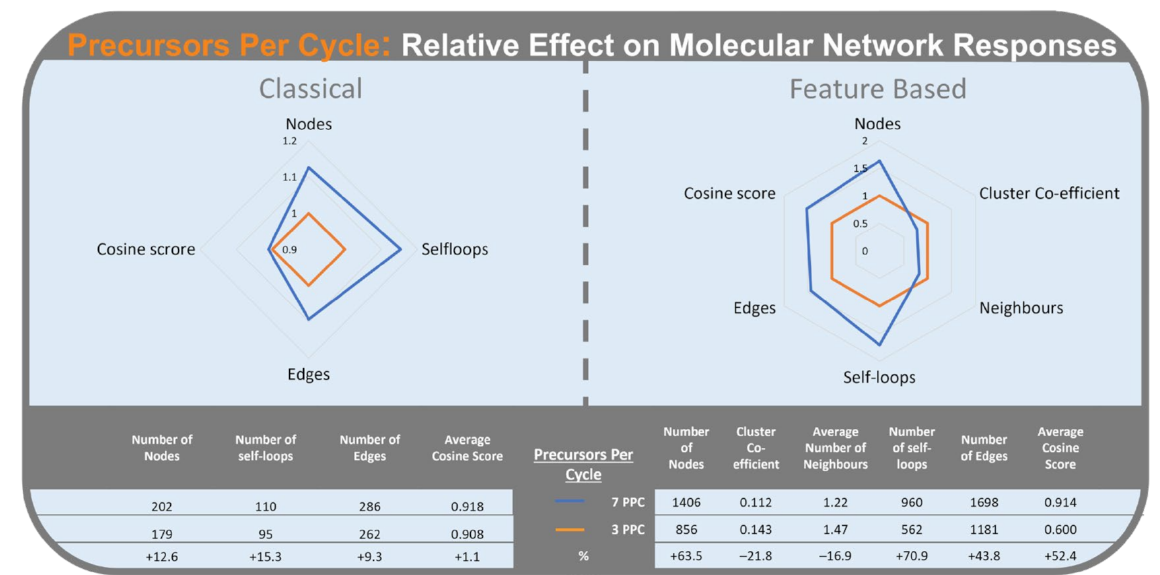
Figure 5. Radar graph of the number of precursors per cycle effect (3 precursors per cycle in orange; 7 precursors per cycle in blue) on the relative change of responses, averaged across the three samples. Classical Molecular Networking ( left ) and Feature-Based Molecular Networking ( right